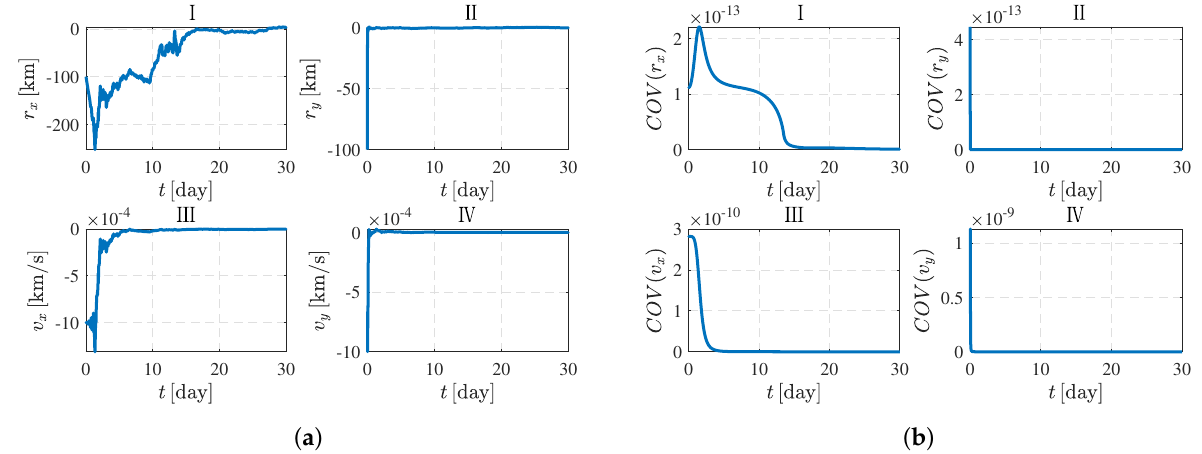
Figure 9. Navigation error results and covariance convergence curve. ( a ) Navigation error. ( b ) Covariance convergence curve.